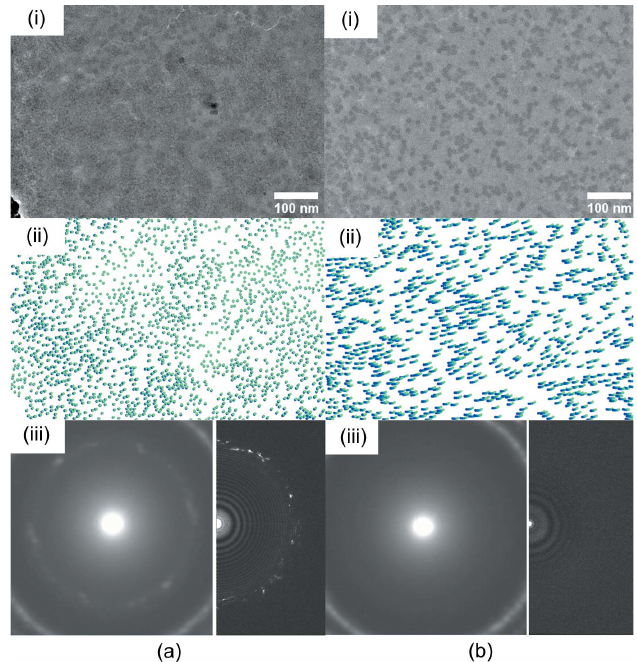
Figure 4 Beam-induced motion, sample thickness and ice for ( a ) sample 3 and ( b ) sample 4. Shown are (i) an image of a foil hole at a fluence of 1.00 e (cid:3) A˚ (cid:3) 2 ; (ii) particle positions measured in the first and fifth frames corresponding to fluences of 0.55 and 5.5 e (cid:3) A˚ (cid:3) 2 , respectively; (iii) sample film thickness map determined by comparing transmitted intensities with and without an energy slit; and (iv) diffraction mode image (left) and FFTof real space image (right).